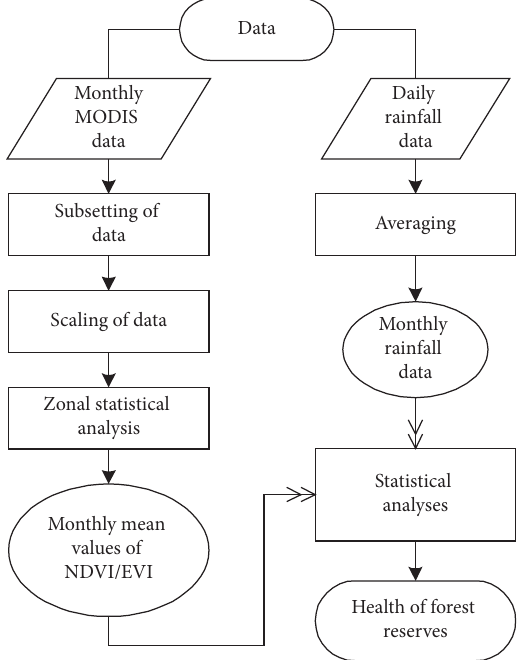
Figure 1: Schematic workflow of the